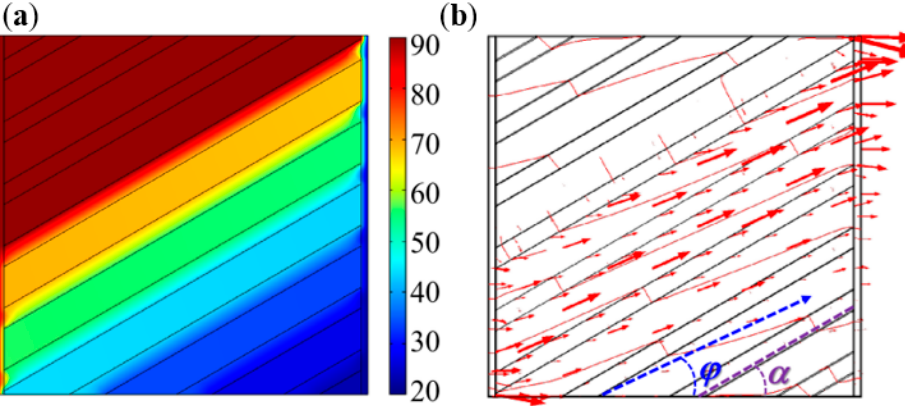
Figure 5. Thermal simulation results for a square unit with α 30 ◦ : ( a ) nephotogram of temperature fields on the surface; ( b ) heat flow direction with an inclined angle ϕ .